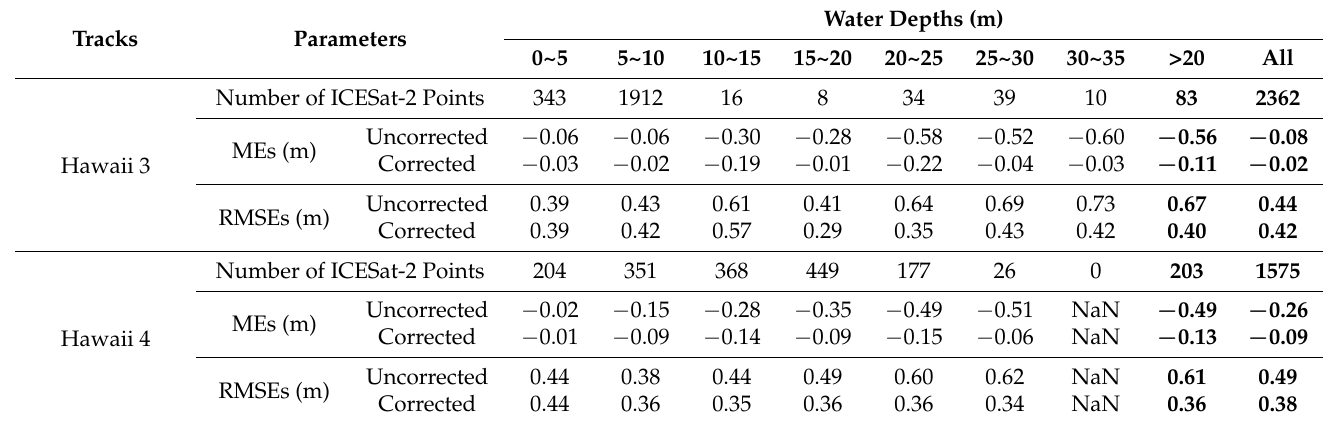
Table 4. Statistics of orthometric height differences between ICESat-2 points and their corresponding truth values before and after water forward-scattering corrections at